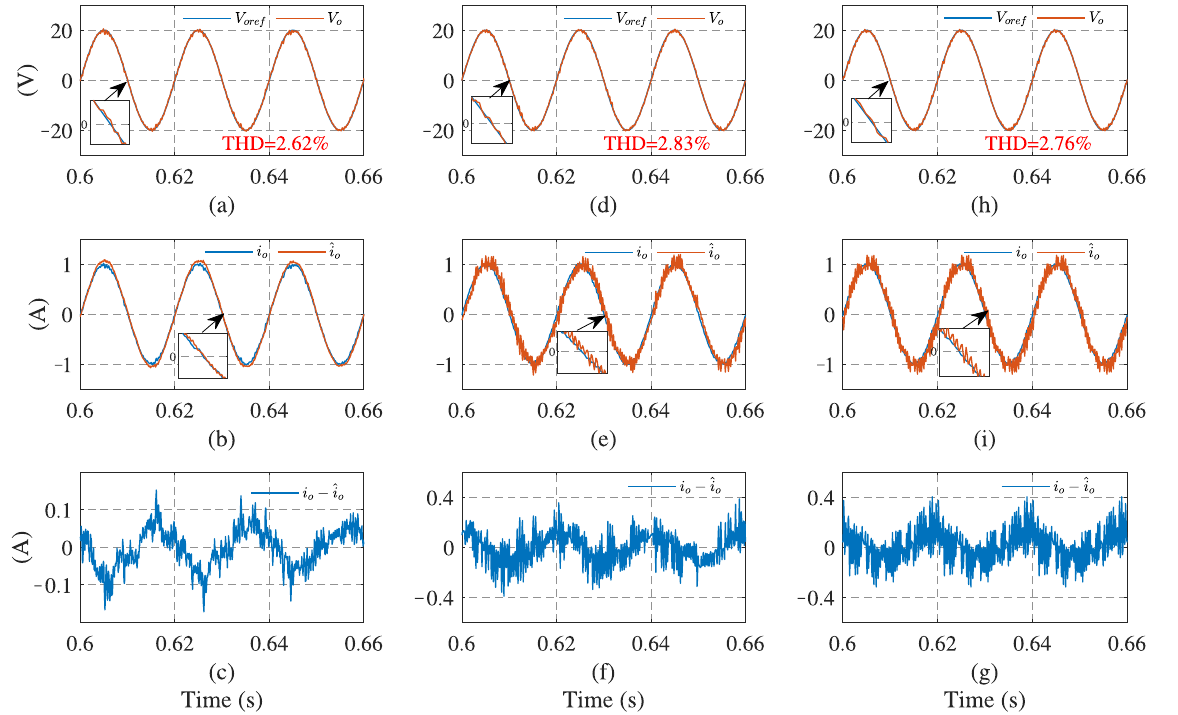
Figure 6. System simulation results using the current estimation method under linear load: ( a , d , h ) out- put voltage of observer, Kalman filter, and low-pass filter, respectively; ( b , e , i ) load currents of the three methods, respectively; ( c , f , g ) current estimation errors of the three methods, respectively.